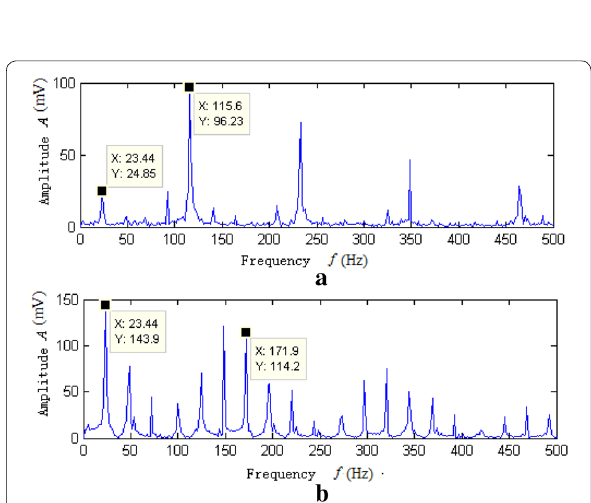
Figure 4 Envelope spectrum of N205: ( a ) outer race defect, ( b ) inner race